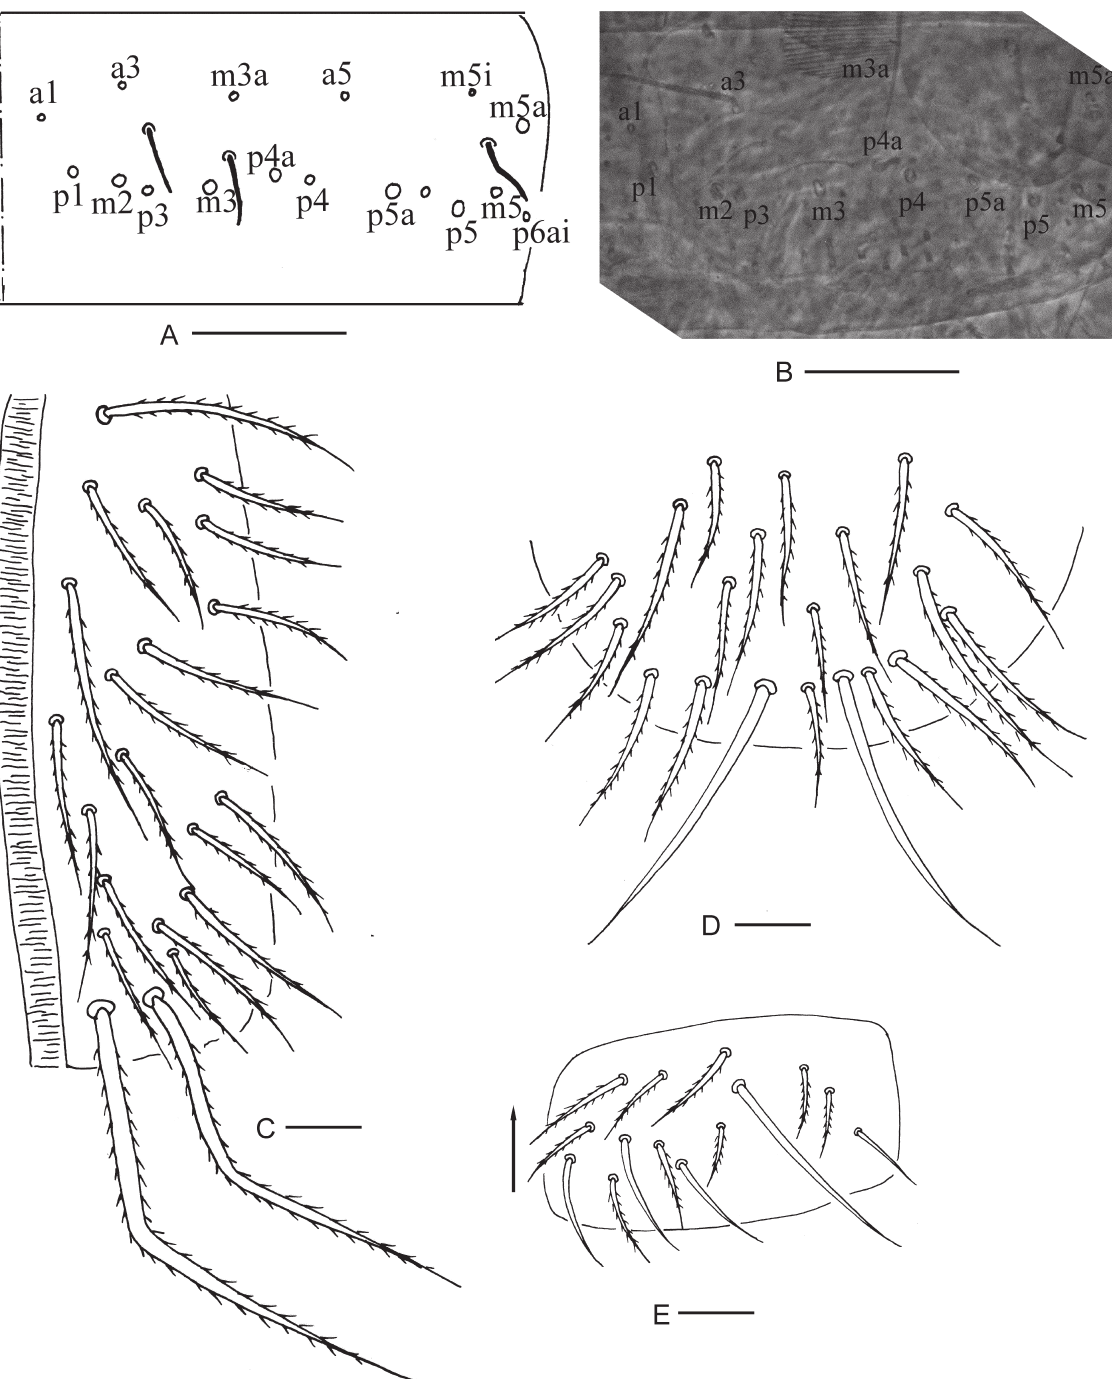
Fig. 8. Lepidocyrtus ( A. ) huizhouensis sp. nov. A–B . Chaetotaxy of Abd. V (right side). C . Anterior face of ventral tube (right side). D . Posterior face of ventral tube (apically). E . Lateral flap of ventral tube. Scale bars: A−B = 15 μm; C−E = 20